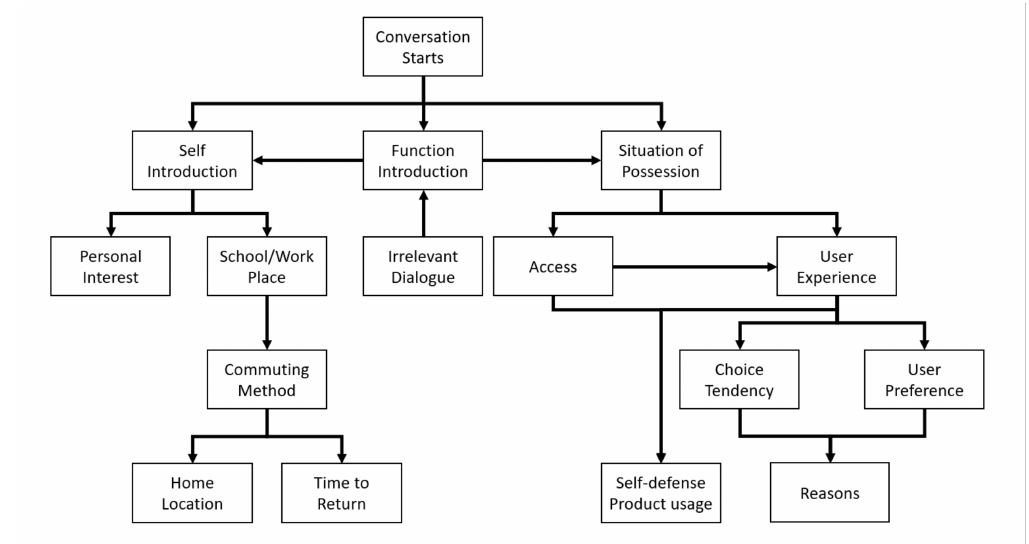
Figure 3. Dialog process map of the userbot